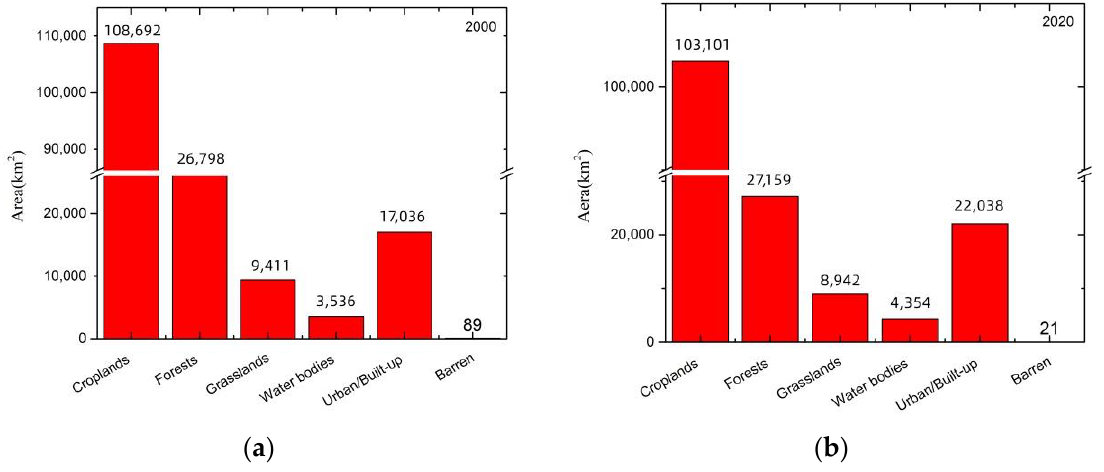
Figure 12. Statistics of each individual land-use type in 2000 ( a ) and 2020 ( b ).